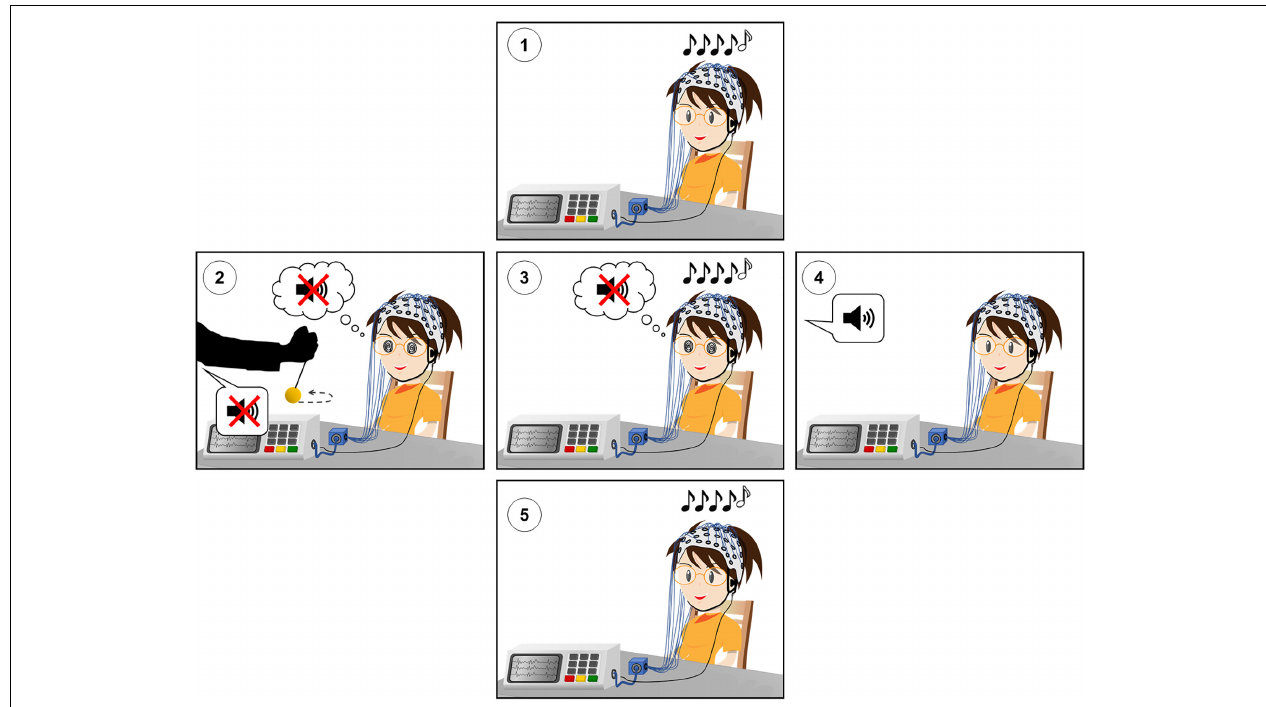
FIGURE 1 | Experimental design of the hypnotic deafness paradigm. (1) Baseline (PRE) session of the auditory odd-ball paradigm. (2) Hypnotic induction and suggestion of radical deafness to elementary sounds. (3) Hypnotically suggested deafness (HYP) session of the auditory odd-ball paradigm. (4) Termination of hypnosis and recovery of subjective experience of sound. (5) Post-hypnotic (POST) session of the auditory odd-ball paradigm. During each session of the auditory odd-ball paradigm, series of five sounds were presented, with the last sound being identical (AAAAA or BBBBB, “standard”) or different (AAAAB or BBBBA, “deviant”) than the first four. High-density scalp EEG was recorded during each experimental